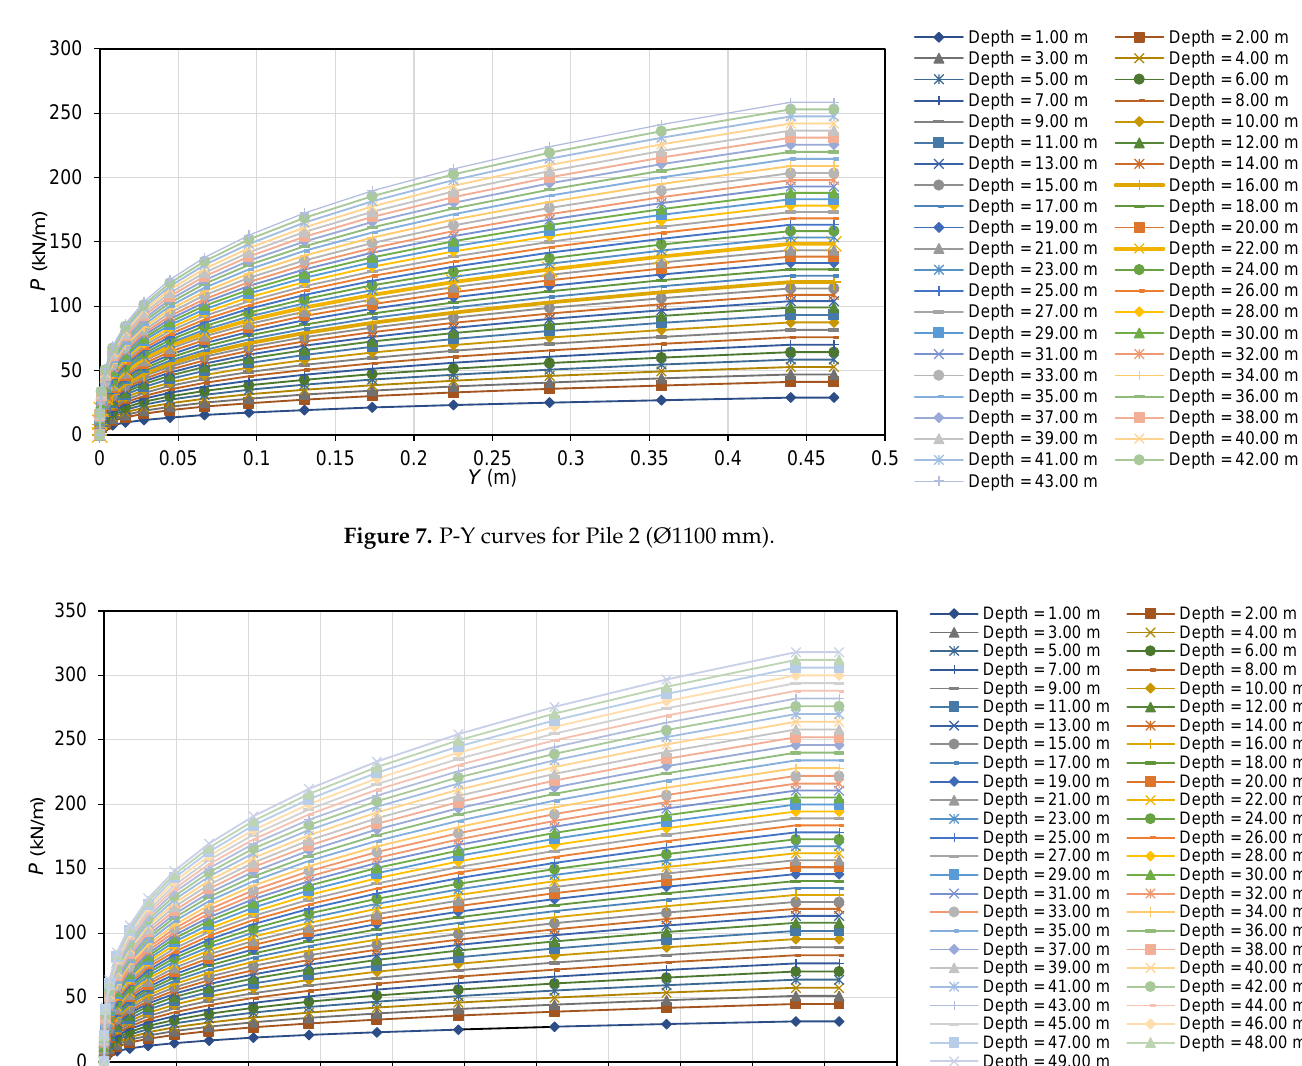
Figure 6. P-Y curves for Pile 1 (Ø 1000 mm).